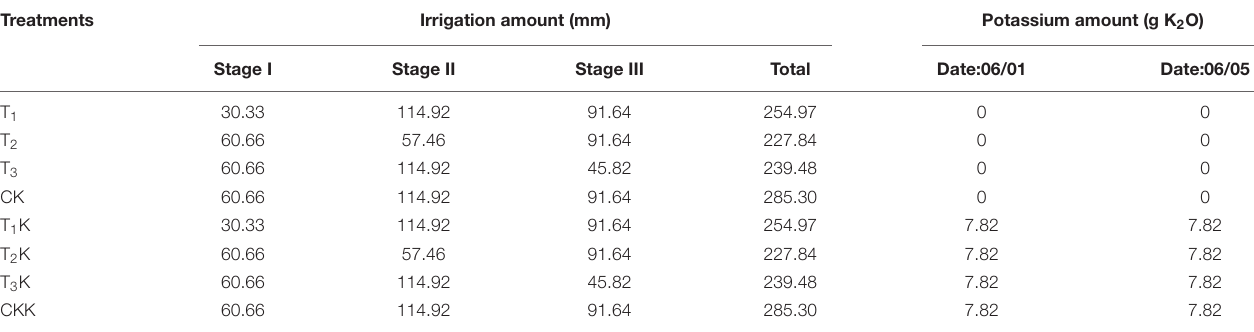
TABLE 1 | Details of irrigation amount and potassium application in different water and potassium treatments in the three stages. Treatments